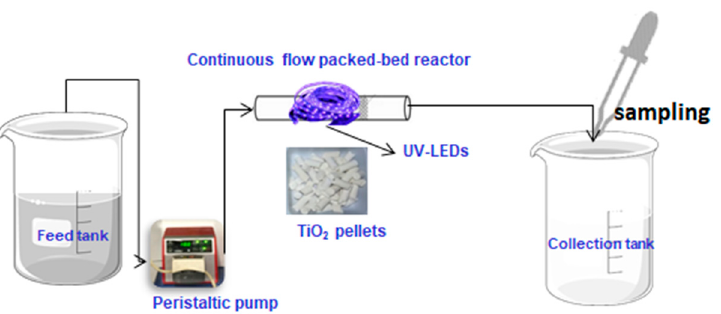
Figure 11. Schematic picture of the experimental apparatus based on continuous-flow photocatalytic microreactor irradiated by UV-LEDs and filled with TiO 2 pellets. Adapted with permission from